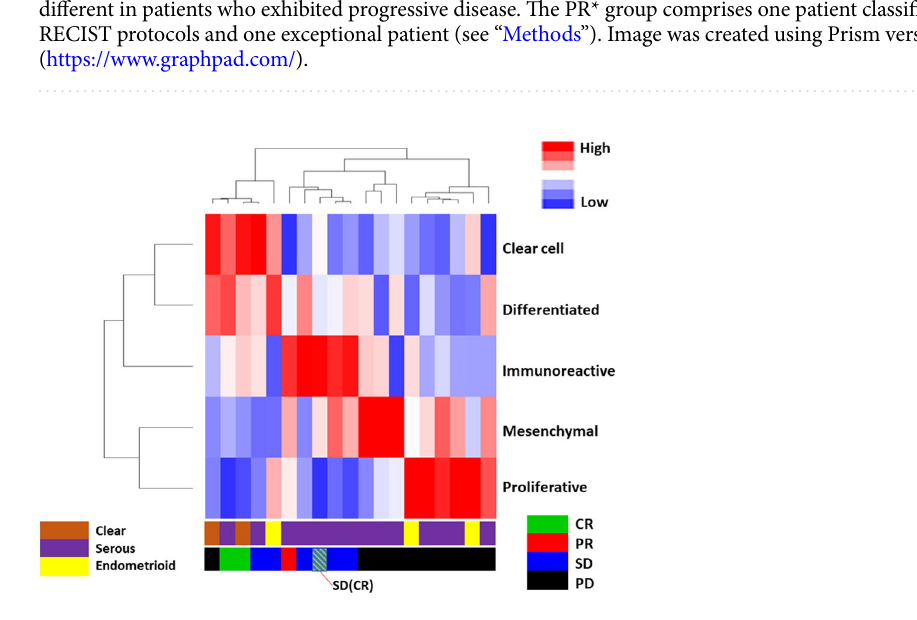
Figure 2. Complementarity of gene signatures in predicting clinical response. Gene signature groups were biclustered, and patient clinical responses were annotated. An additional annotation track of histopathological subtype is provided. Score values were normalized by centering on the mean for each signature, and average linkage was used to create the dendrogram. Combinations of signature groups reinforce prediction of clinical response to therapy. Image was created using Python 3.0. (https:// www. python. org/ downl oad/ relea ses/3.